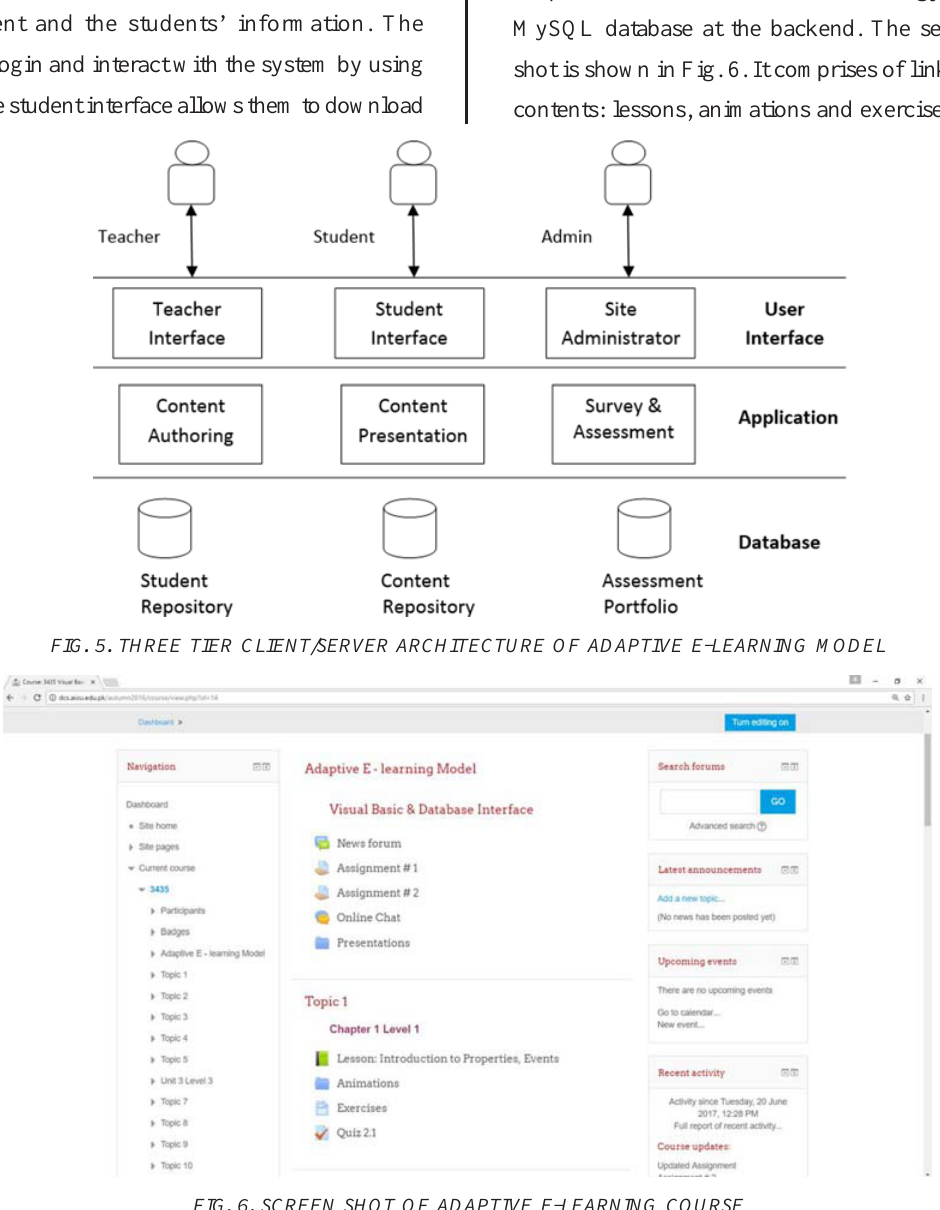
FIG. 6. SCREEN SHOT OF ADAPTIVE E-LEARNING